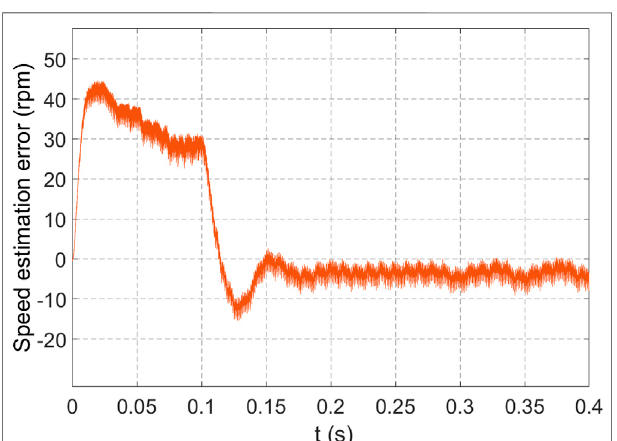
FIGURE 4 | Speed estimation error.